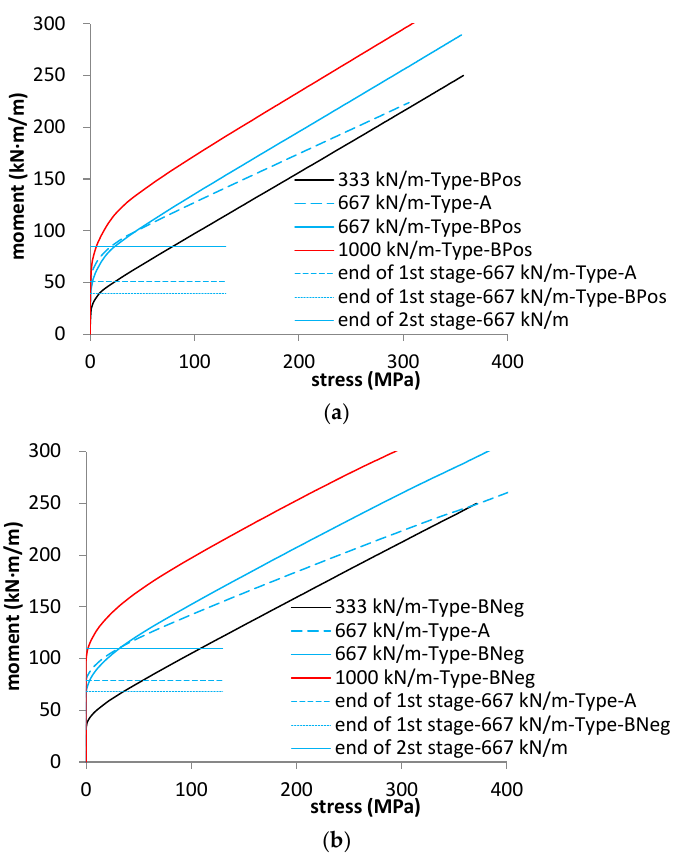
Figure 21. Evolution of the bolt stresses with increasing bending moment under constant axial force: ( a ) positive cases; ( b ) negative cases.